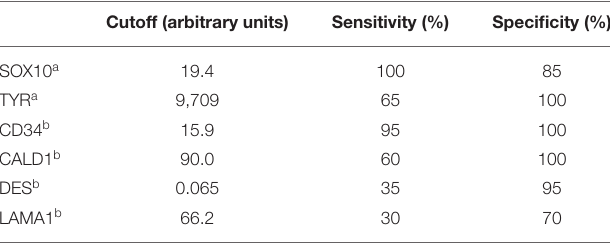
a Sensitivity and specificity were calculated for oral malignant melanoma (OMM) relative to soft tissue sarcoma (STS). b Sensitivity and specificity were calculated for STS relative to OMM.